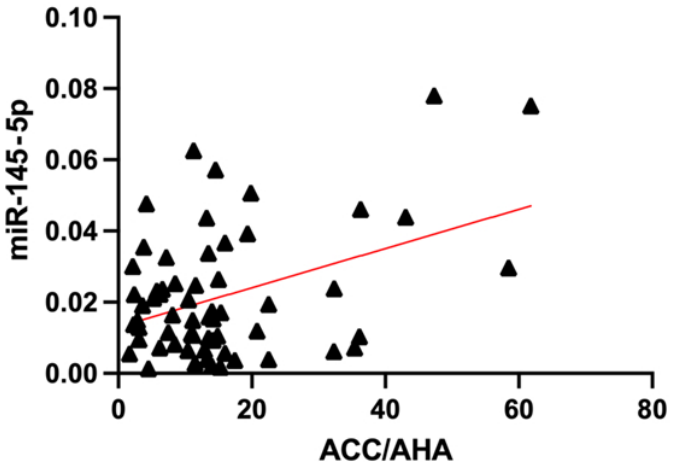
Figure 4. Relationship of miR-145-5p relative plasma levels in patients with different values of CVR estimated by ACC/AHA.